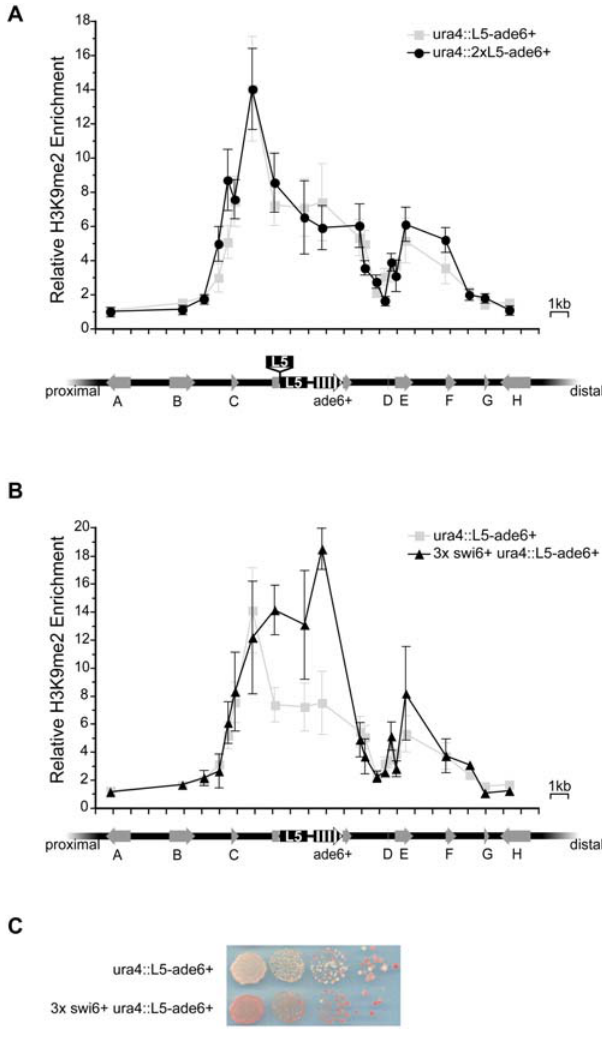
Figure 4. The denovo heterochromatin domain is shaped by the dosage of trans-acting factors. (A) H3K9me2 enrichment in the presence of an additional copy of L5 is shown in black circles. The extra copy of L5 is shown above the ura4 genomic region, with insertion site indicated, compared to strains bearing only one copy of L5 (light grey squares). (B) H3K9me2 enrichment in strains bearing extra copies of the swi6 + gene, shown in black triangles. (C) Serial dilution analysis of ade6 + expression in wild type and 3 6 swi6 +